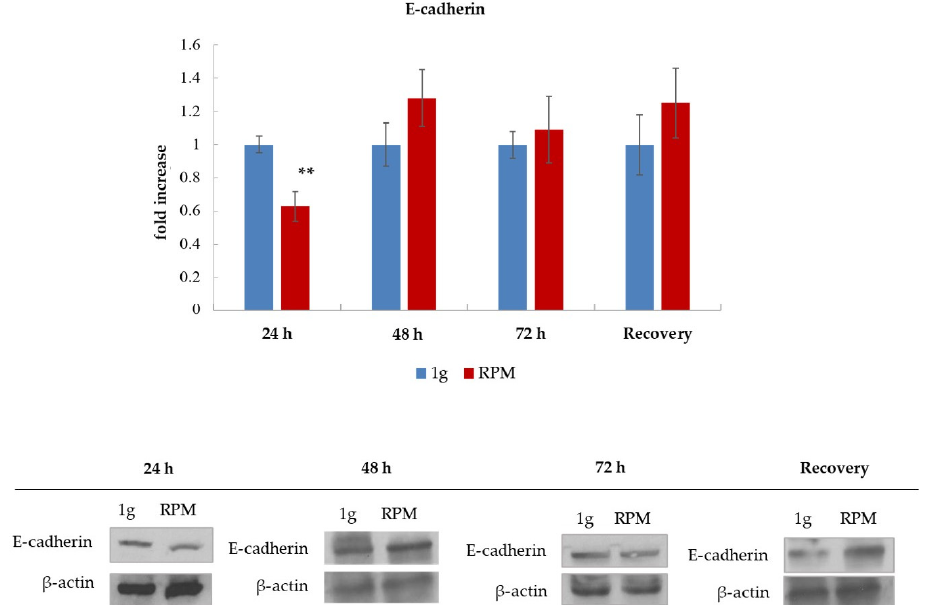
Figure 1. Western blot analyses of E-cadherin in human keratinocytes (HaCaT) cells cultured in normal gravitational condition (1g) and microgravity conditions (random positioning machine, RPM) for 24 h, 48 h, 72 h, and after recovery experiments. Columns represent the densitometric quantification of optical density (OD) of E-cadherin signal normalized with the OD values of ß-actin used as a loading control. Values are expressed as a fold increase of control. Values are means of three independent experiments; SD is depicted as vertical bars ** p < 0.01 vs. 1g control by an unpaired two-tailed t -test. On the bottom, a panel of representative Western blot analyses is reported.